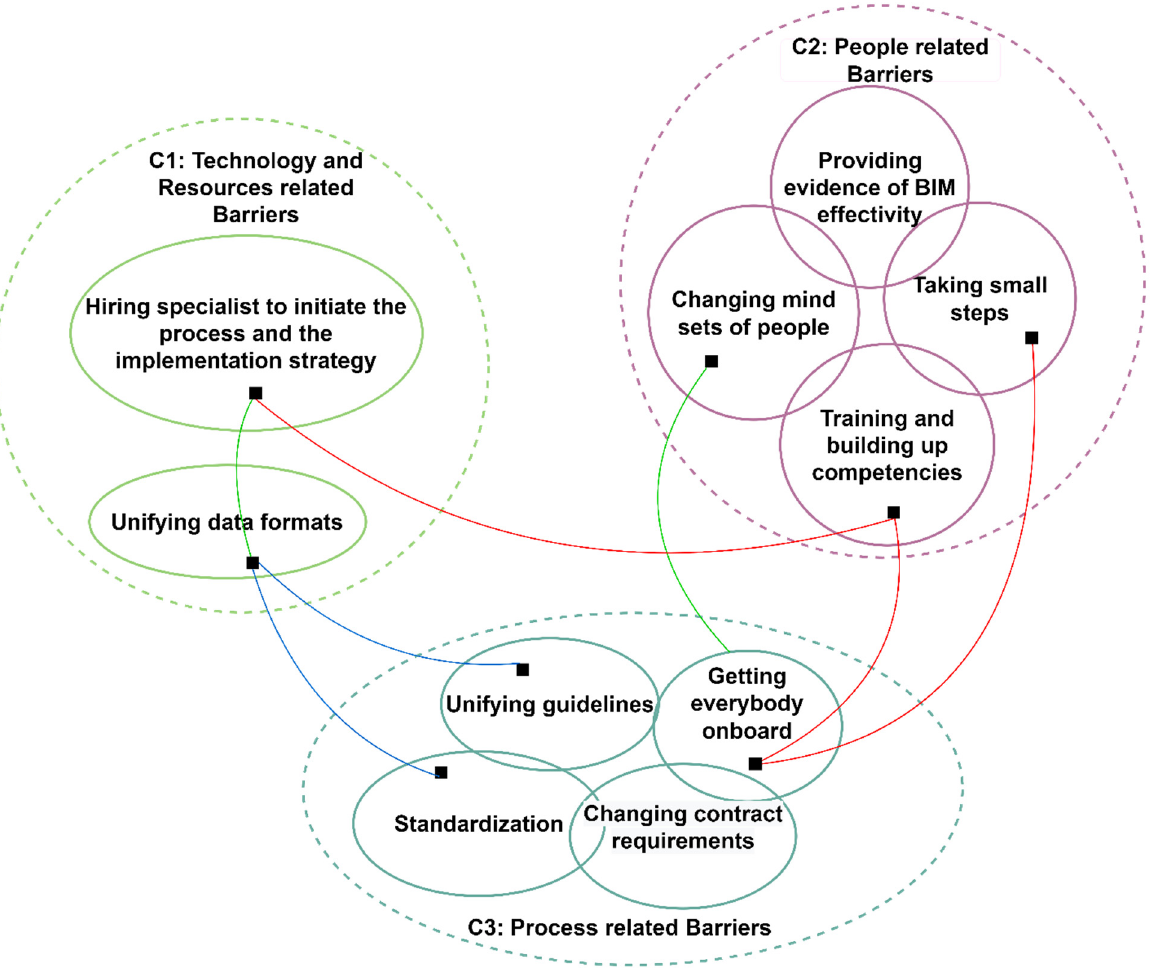
Figure 3. The proposed conceptual model to overcome BIM implementation barriers.